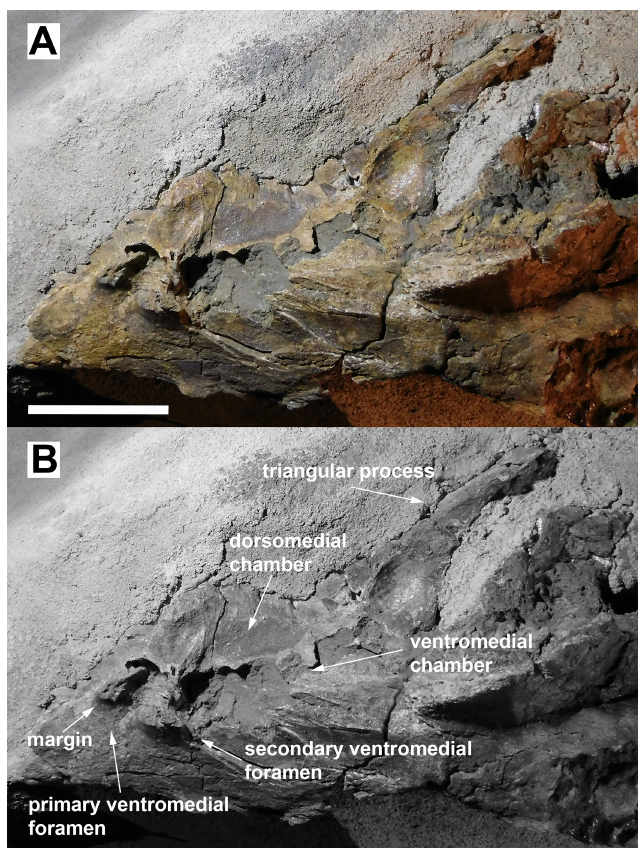
Figure 9. Medial view of the partial right premaxilla of MOR 1122. A) The premaxilla preserves partial ventromed- ial foramina and portions of the internal chambers. B) The primary ventromedial foramen is partially bound rostrally by an obliquely oriented margin. Though this margin is incom- plete, it indicates a minimum diameter of 2.4 cm for the primary foramen. Scale, 10